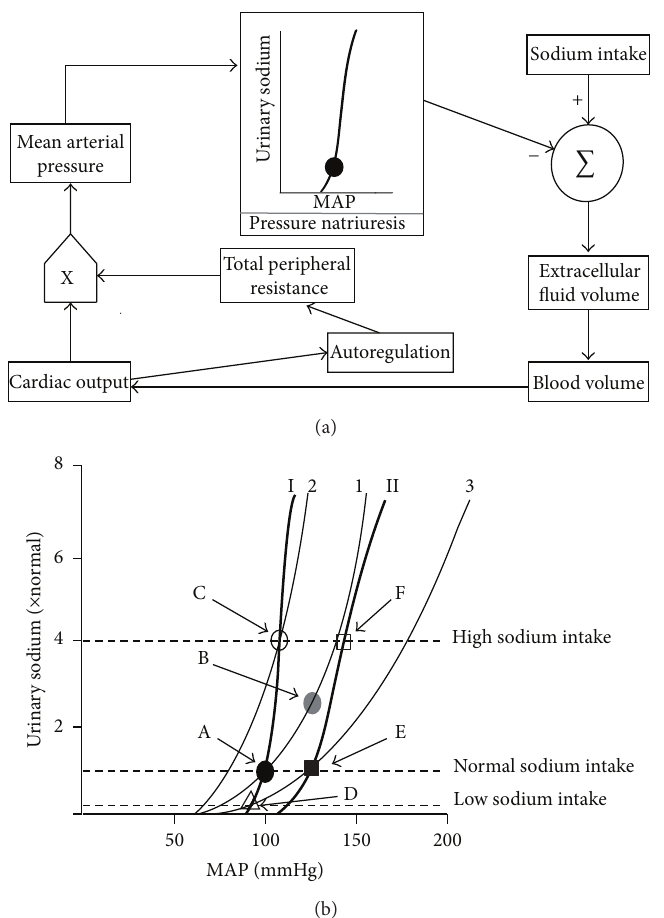
Figure 1: The renal-mean arterial pressure (MAP) set-point model as proposed by Guyton et al. [13–15]. (a) Basic renal-body fluid feedback mechanism for long-term regulation of blood pressure and body fluid volumes. (b) Normalized urinary sodium excretion is plotted as a function of the MAP to show the pressure natriuresis relationships, at different sodium intake levels, corresponding to the normal condition (acute renal function curves 1, 2, and 3 and chronic renal function curve (I)) and to a mild hypertension condition (chronic renal function curve (II) ) . See further details in